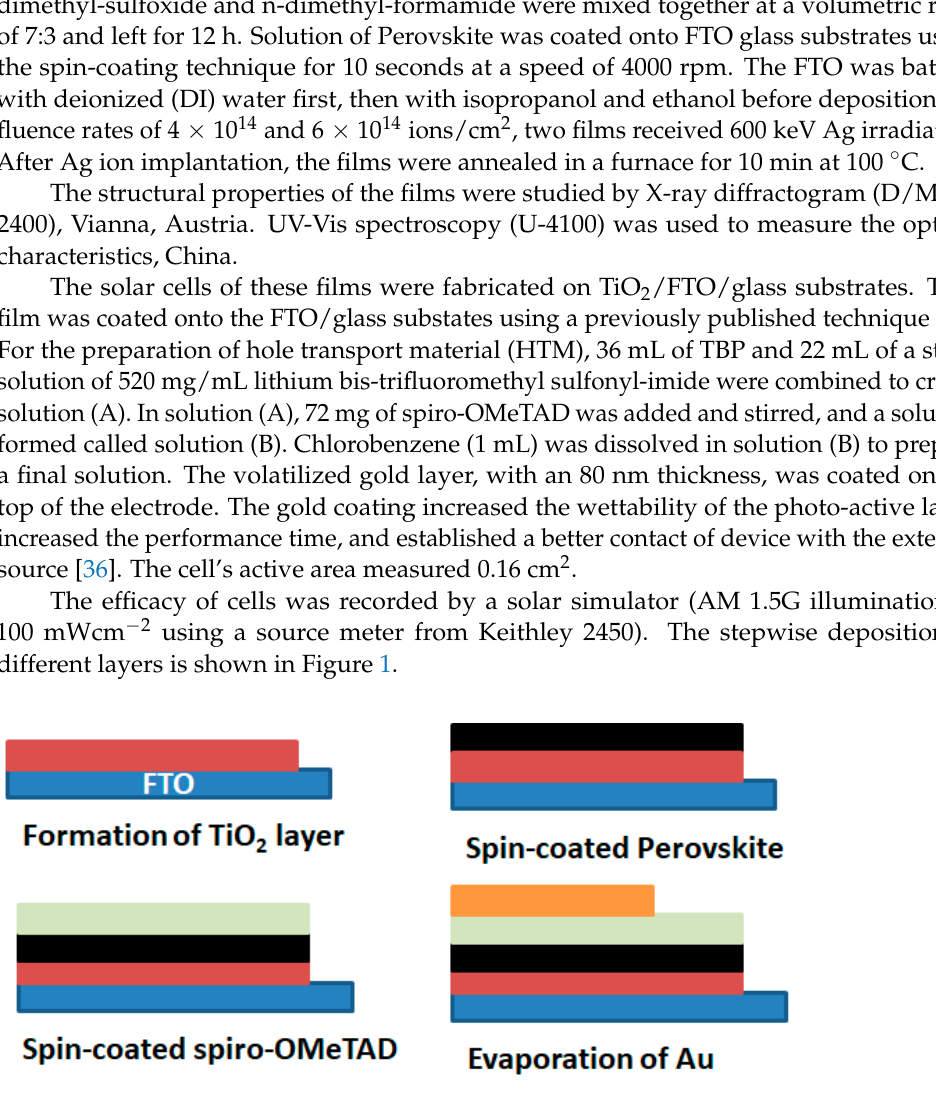
Figure 1. Stepwise coating of the TiO 2 , perovskite, spiro-OMeTAD, and Au layers.